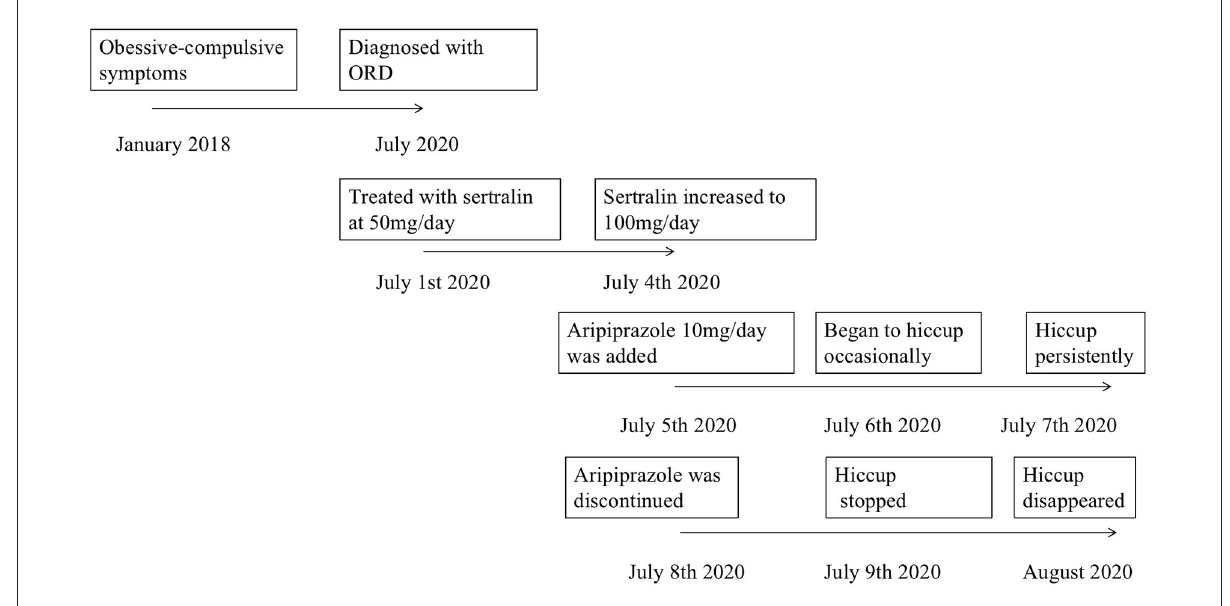
FIGURE1 The timeline of